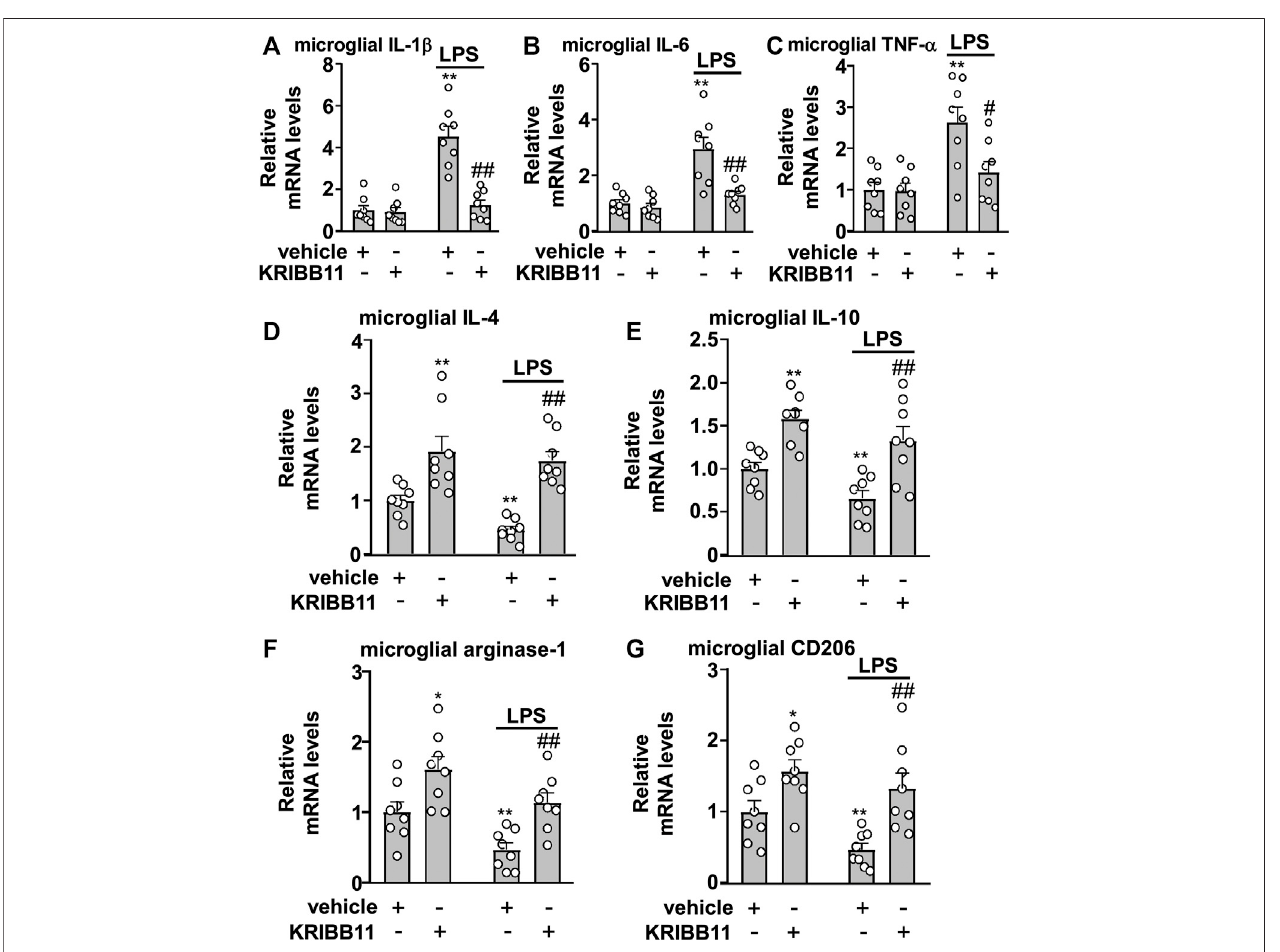
FIGURE4| EffectsofKRIBB11onLPS-inducedin fl ammatoryresponsesinprimarycultured microglia. (A ‒ C) Quantitativeanalysisshowedthepreventiveeffectof KRIBB11 pretreatment (3 μ M, 1 h) on LPS (1 μ g/ml, 8 h)-induced increases in the expression levels of IL-1 β (A) , IL-6 (B) , and TNF- α (C) mRNA in primary cultured microglia ( n = 8, ** p < 0.01 vs. vehicle, # p < 0.05 or ## p < 0.01 vs. vehicle + LPS). (D ‒ G) Quantitative analysis showed the preventive effect of KRIBB11 pretreatment (3 μ M, 1 h) on the expression levels of IL-4 (D) , IL-10 (E) , arginase-1 (F) , and CD206 (G) mRNA in primary cultured microglia treated with or without LPS (1 μ g/ml, 8 h; n = 8, * p < 0.05 or ** p < 0.01 vs. vehicle, ## p < 0.01 vs. vehicle + LPS). Data are shown as mean ±